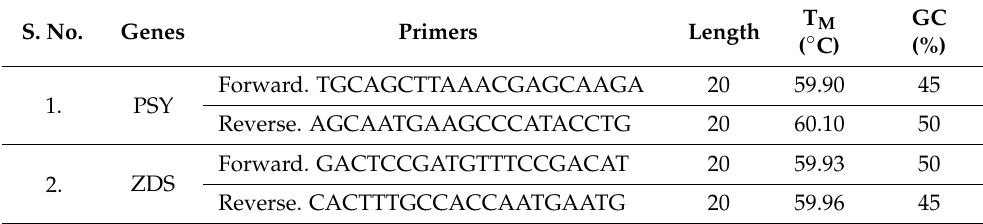
Table 3. List of primers of bioactive genes designed by Primer 3.0 tool. S.